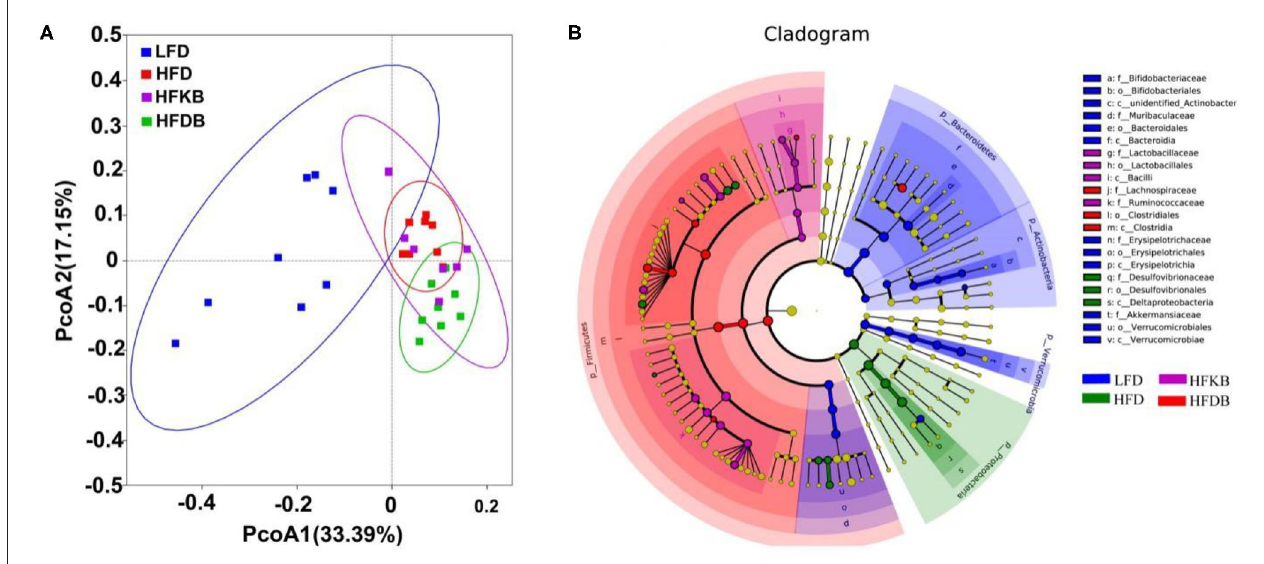
FIGURE 5 | Effects of black tea on overall microbial structure. (A) principal coordinates analysis; (B) linear discriminant analysis effect size comparison of microbiota for LFD, HFD, HFKB, and HFDB. substances play vital roles in distinguishing between KBT and